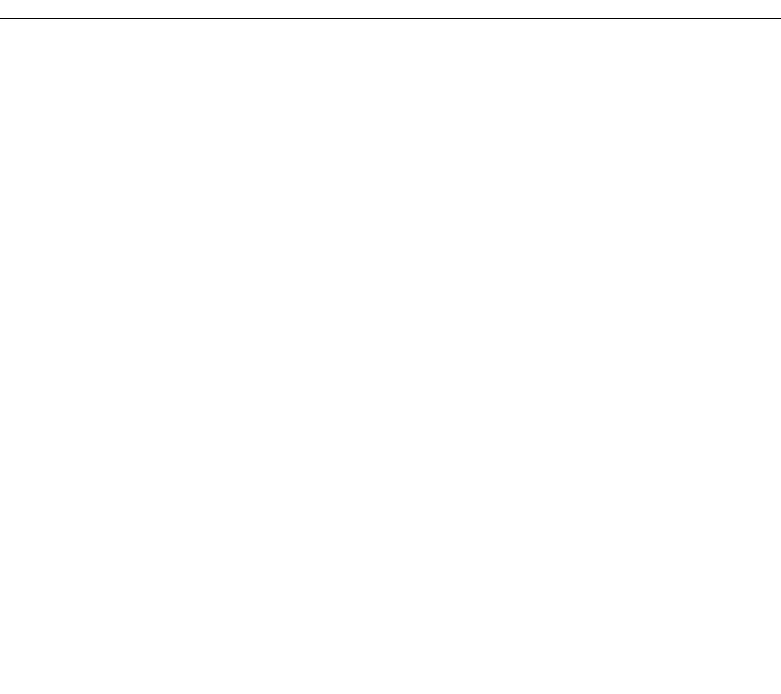
Figure 2. Effects of polygodial concentrations (25–350 µg/mL) found in TPL extract and incubation time on the spore viability of pathogenic and spoilage fungi.